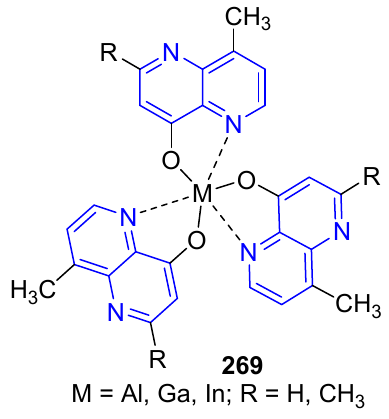
Figure 33. Metal complexes of group III as OLEDs.